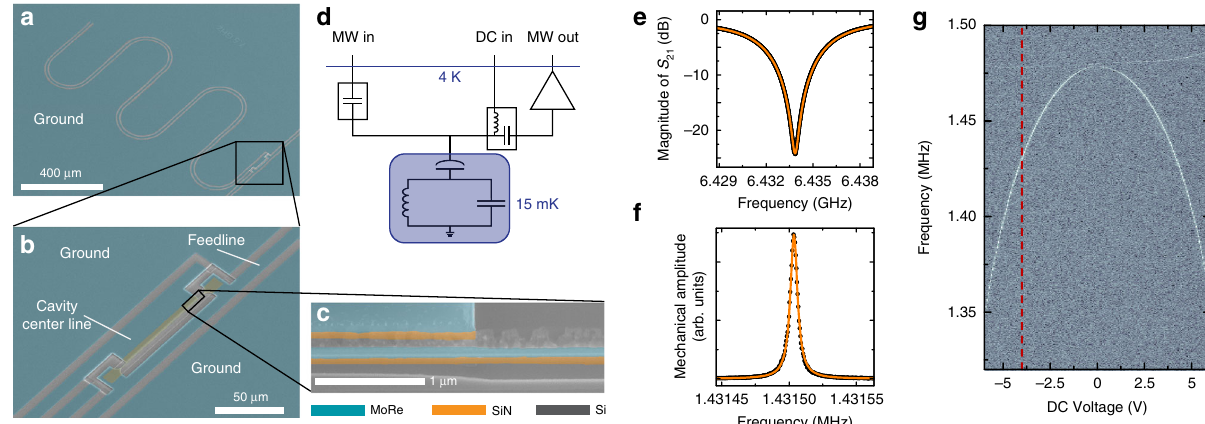
Fig. 1 Superconducting circuit nano-electromechanical system with electrostatic and low-frequency access. a False-color scanning electron microscopy image of a superconducting quarter-wavelength cavity (here for ω c = 2 π ⋅ 7.5 GHz), capacitively side-coupled to a coplanar waveguide feedline. The molybdenum-rhenium (MoRe) metallization is shown in blue and the silicon (Si) substrate in gray. b Zoom into the coupling capacitance region, where the mechanical nanobeam as part of the coupling capacitance is visible. The dimensions of the beam, which consists of MoRe on top of high-stress silicon- nitride (Si 3 N 4 ), are 100 μ m × 150 nm × 143 nm. c A magni fi ed view of the suspended nanobeam. d Simpli fi ed circuit and measurement scheme, showing a lumped element circuit representation of the device as well as the microwave (MW) input and output lines (including a DC block and high electron mobility transistor ampli fi er shown as triangle) and the DC (directed current) input line connected to the microwave lines via a bias-tee. A more detailed version of the setup is given in Supplementary Note 1. e Cavity resonance data (black) and fi t curve (orange). From the fi t, we extract the cavity resonance frequency ω c = 2 π ⋅ 6.434GHz and the internal and external linewidths κ i = 2 π ⋅ 370 kHz and κ e = 2 π ⋅ 5.7 MHz, respectively. f Resonance curve of the mechanical oscillator readout via the superconducting cavity. Data are shown as black dots, a Lorentzian fi t as orange line. From the fi t we extract the mechanical resonance frequency Ω m = 2 π ⋅ 1.4315 MHz and a quality factor Q m = 195,000. g Optomechanically detected excitation spectrum of the nanobeam vs. applied DC voltage. The bright line resembling an inverted parabola represents the resonance of the in-plane mode, which was used everywhere throughout this paper. The thin second line around 1.48 MHz corresponds to the mechanical out-of-plane mode. The red dashed line at V dc = − 4 V indicates the voltage operation point we chose to